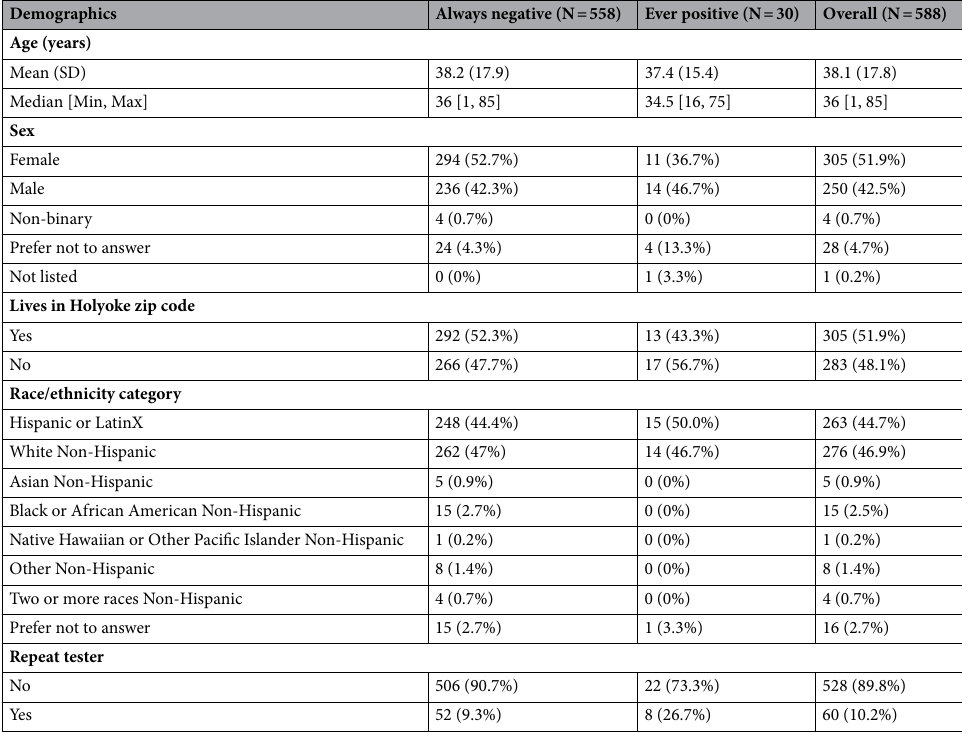
Table 1. Demographics of unique study participants who enrolled in the CareStart Rapid Antigen Test evaluation at the Stop the Spread COVID-19 testing site in Holyoke,